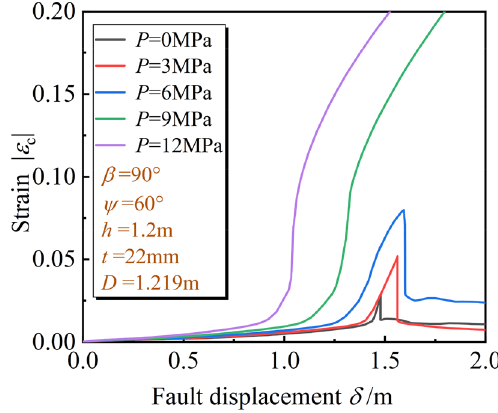
Figure 14. Variation of ε c with δ under different P.